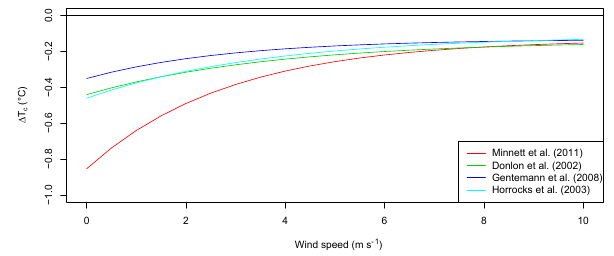
Figure 7. Coefficient of determination and RMSE of the SML tem- perature in relation to temperature at other depths.